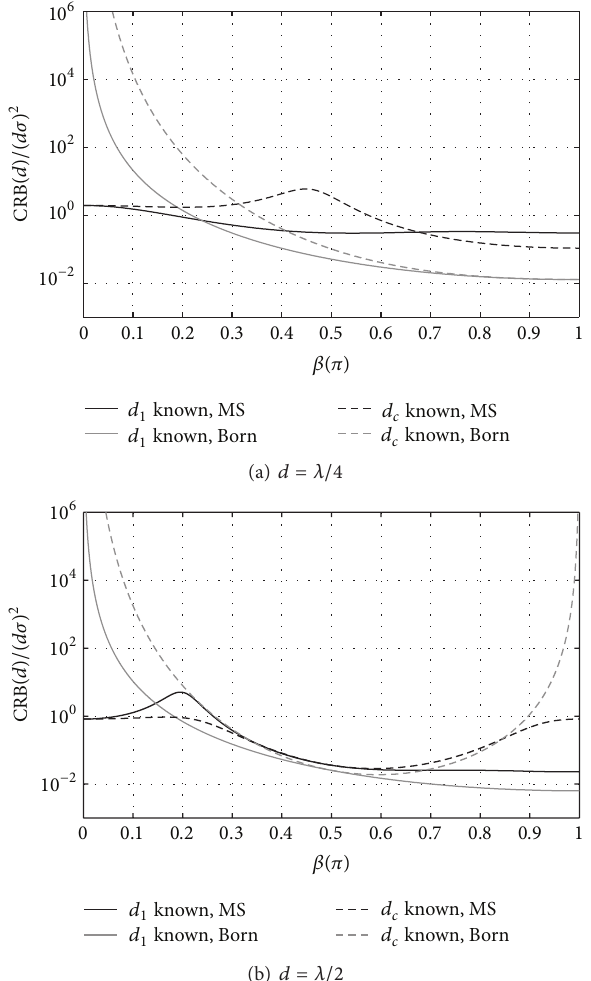
Figure 2: CRB (𝑑) as the observation angle 𝛽 varies, normalized by (𝑑𝜎) 2 , for target separations 𝑑 = 𝜆/4 and 𝑑 = 𝜆/2 . The incidence angle is 𝛼 = 0 and the scatterer strengths are 𝜏 1 = 1 = 𝜏 2